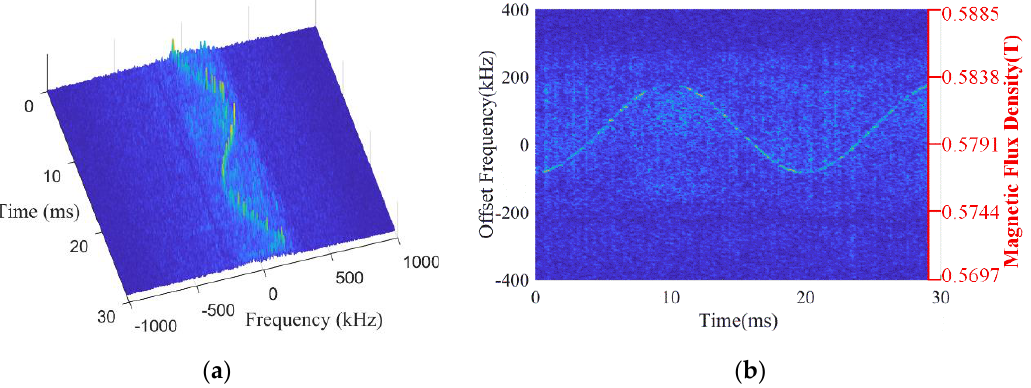
Figure 15. The time − frequency analysis results: ( a ) The 3D STFT diagram. ( b ) The inverted magnetic flux density of the mixed magnet vs. time variation.